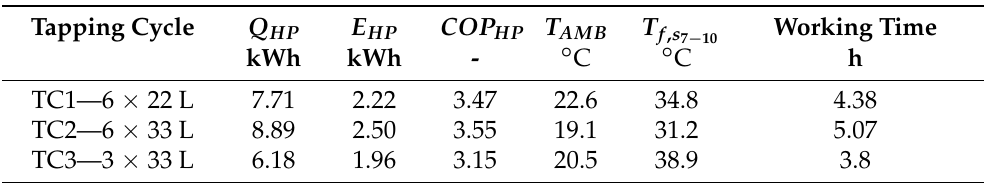
Figure 3. Heat pump useful thermal power (Q), power consumption (P) and coefficient of perfor- mance ( COP ) during tank stratification experiments. Table 4. Heat pump performance during tank stratification experimental results for tapping cycles TC1, TC2, and